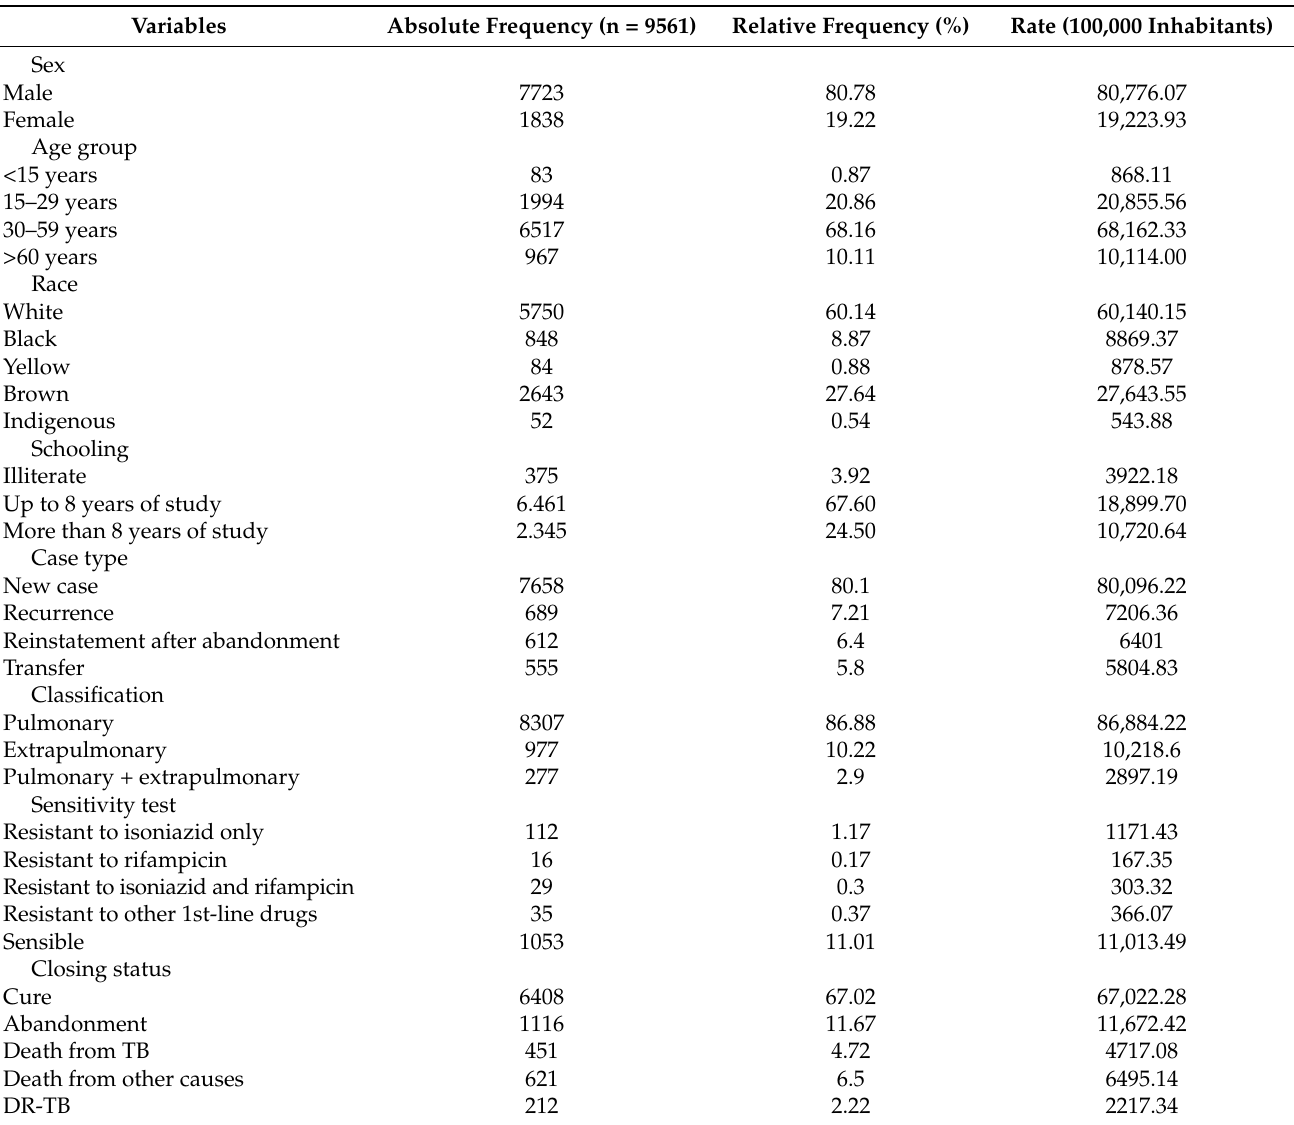
Table 1. Clinical characteristics of TB patients, Paran á , Brazil